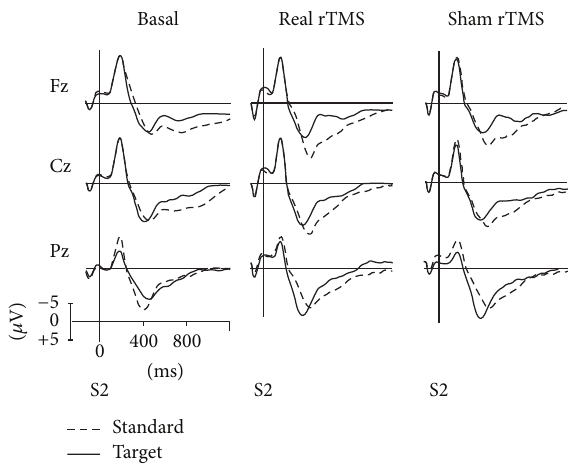
Figure2:ERPstracesinmidlinescalplocationsfortargetandstand- ard stimulus at basal condition, post-real rTMS, and post-sham rTMScollapsedforconditionforallsubjects.Theanalysisepochwas 1.3 s with a 100ms prestimulus baseline before stimulus. ERPs were pass-filtered